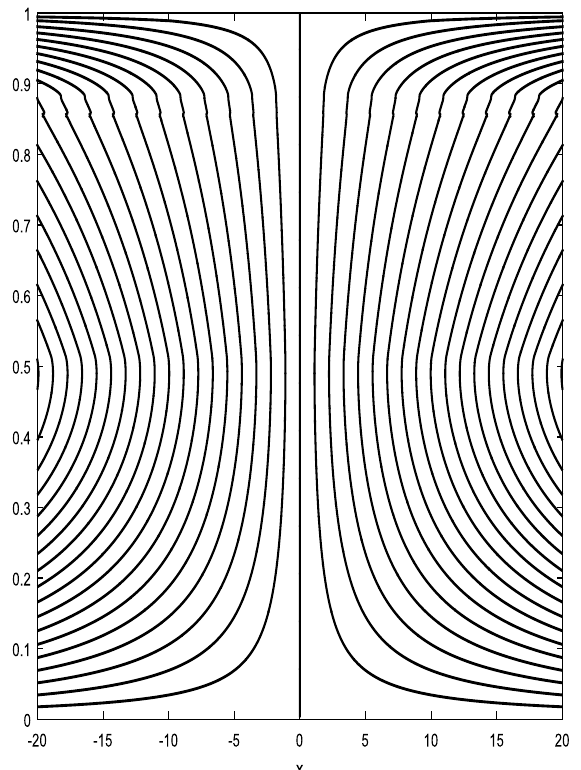
Figure 39. Stream lines profile at F = 0.6 and Da =